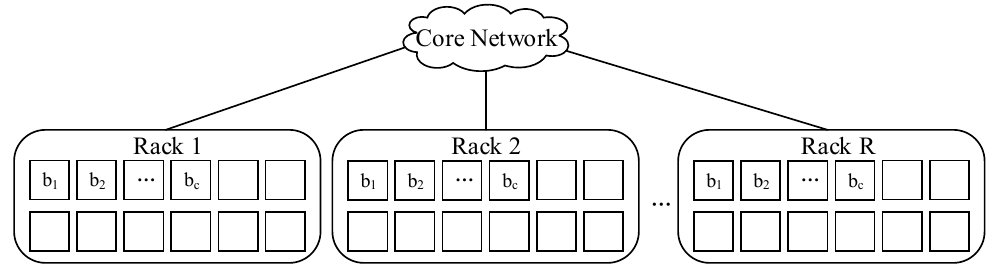
Figure 2. A kind of placement across R racks .